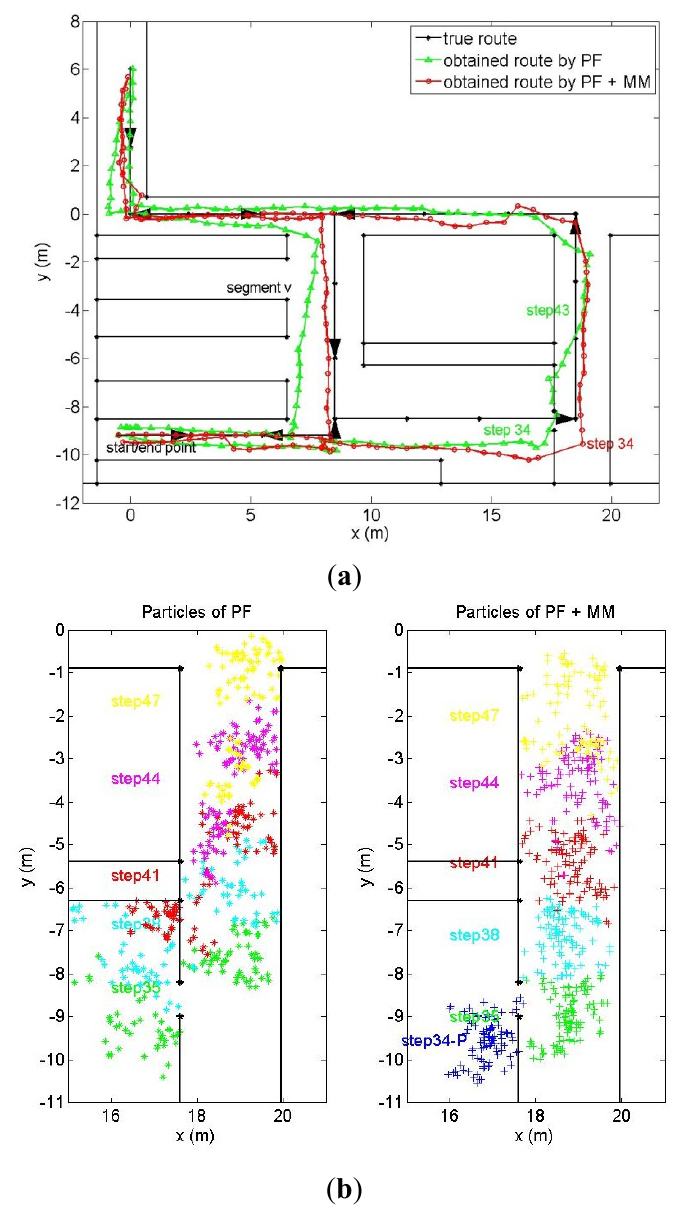
Figure 5. Performance comparison of particle filter (PF) and PF + MM (map